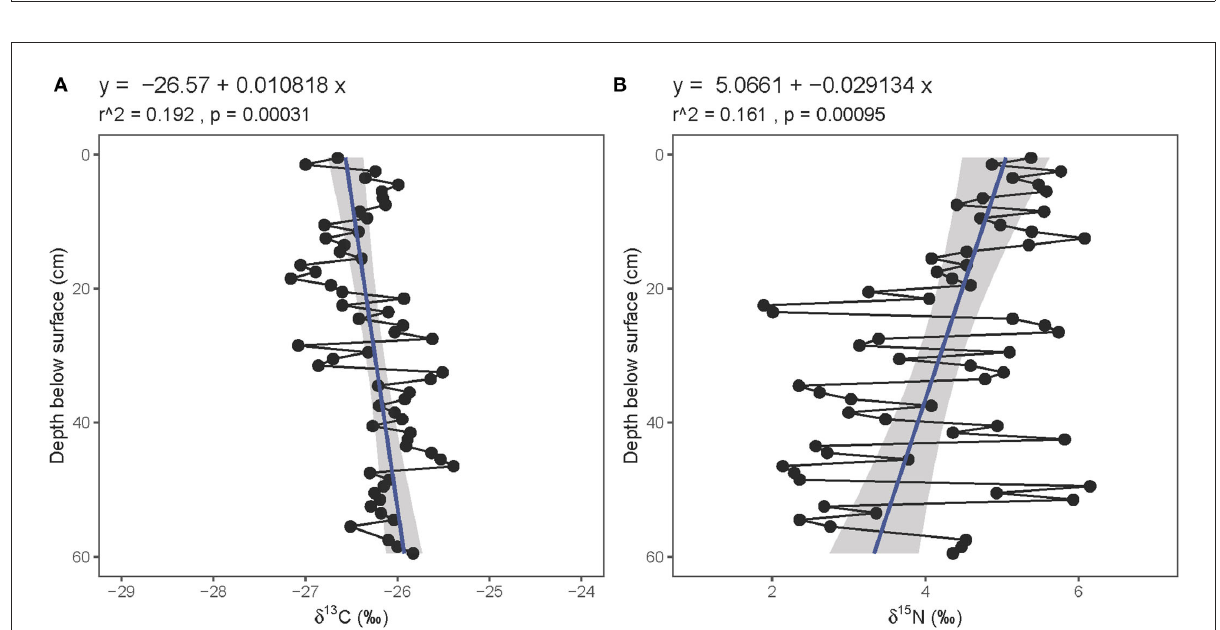
FIGURE5 Relationship between guano (A) δ 13 C (bulk) and (B) δ 15 N (solvent-extracted) values with depth below surface. Linear regression line (blue) plotted with standard error (gray).